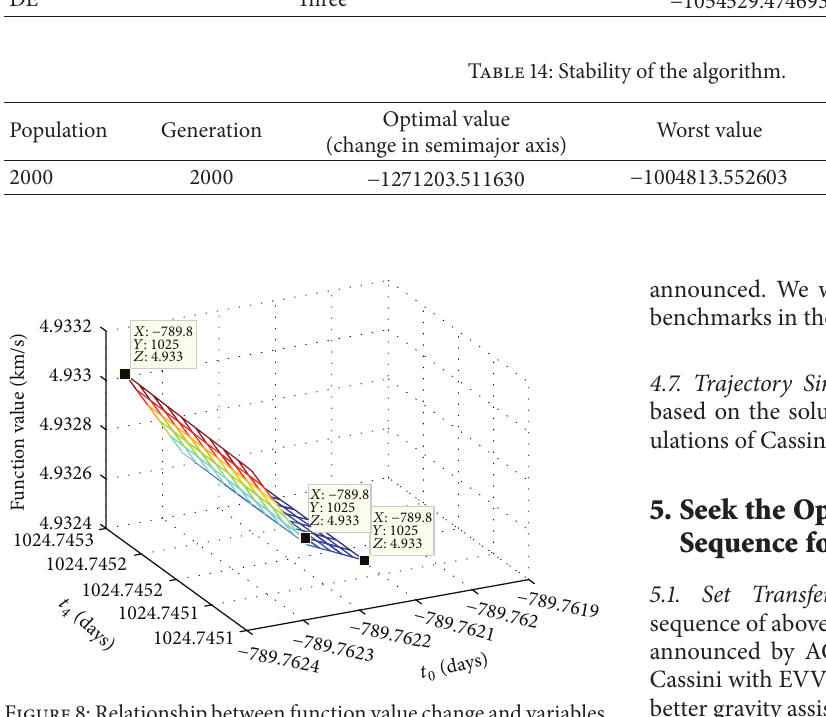
Figure 8: Relationship between function value change and variables 𝑡 𝑡 0 and 4 .